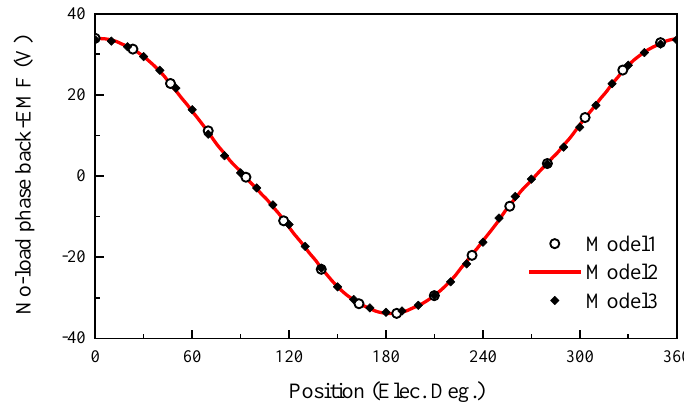
Figure 8. Peak detent force variation vs. section distance.